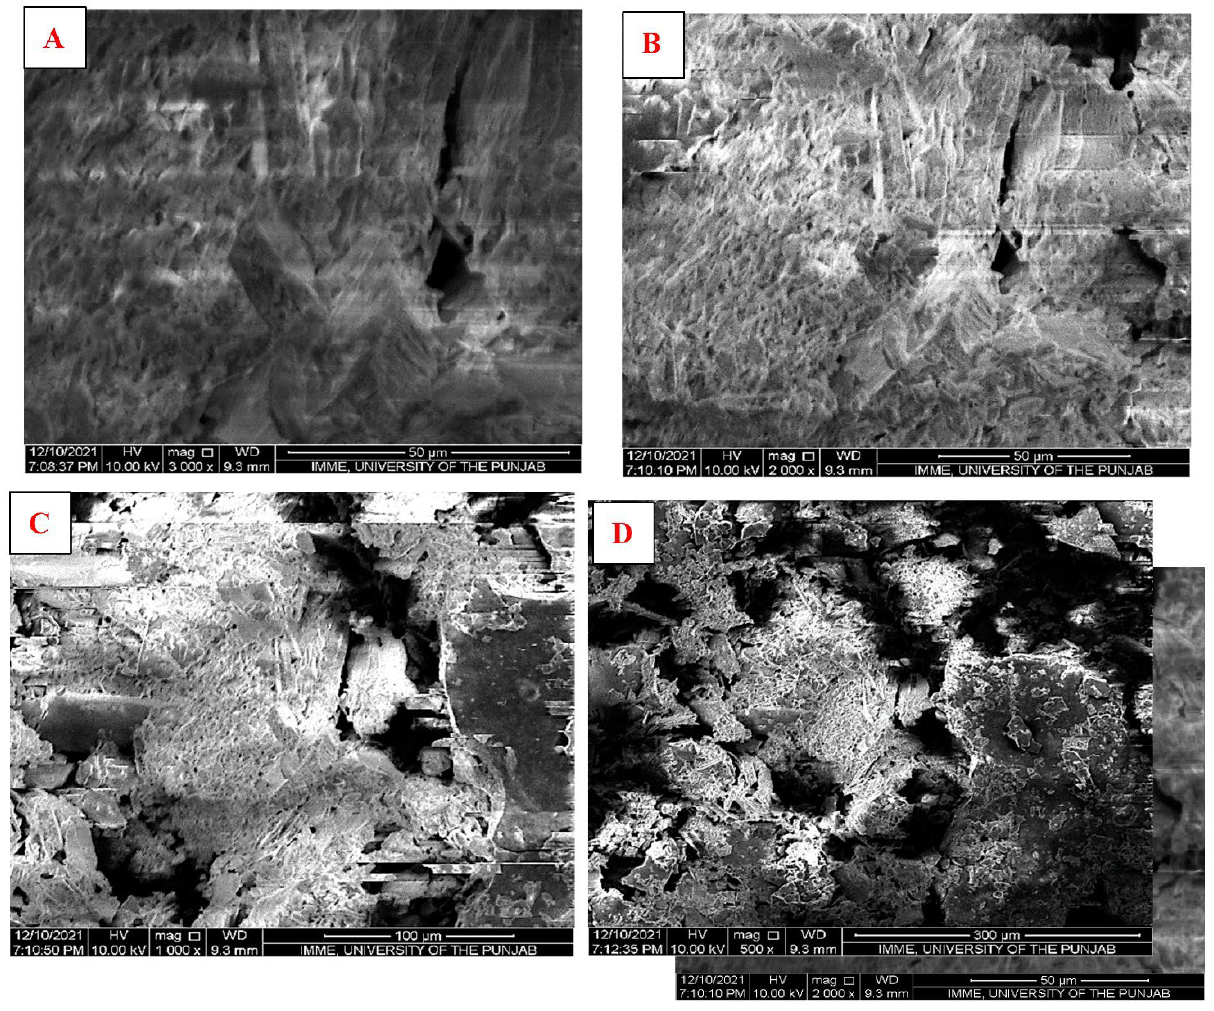
Figure 4. SEM micrograph of silver nanoparticles (BP-AgNPs) 3000 × ( A ), 2000 × ( B ), 1000 × ( C ) and 500 × ( D ) magnification.